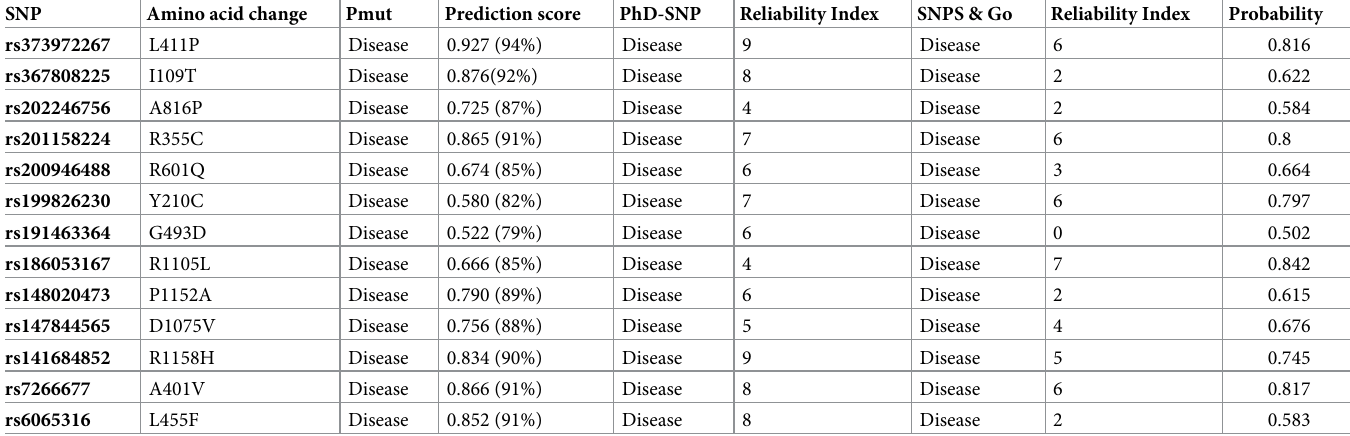
Table 2. Prediction of disease associated nsSNPs by Pmut, PhD-SNP & SNPS&GO.